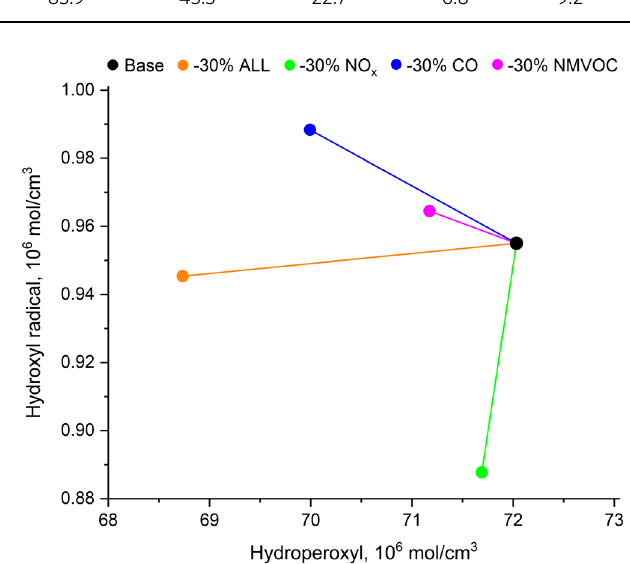
Fig. 2 The oxidative capacity of the troposphere under different background conditions. By reducing emissions of individual precursors by 30% (NO x , CO, NMVOC), and all together (ALL) changes the concentrations of hydroxyl radical and hydroperoxyl. The oxidative capacity of the atmosphere to a great extent controls the abundance of most trace gas species, hence affecting CH 4 lifetime and concentration of O 3 (see text for details). Values are averaged globally within the vertical domain extending from surface to 100 hPa and modelled by